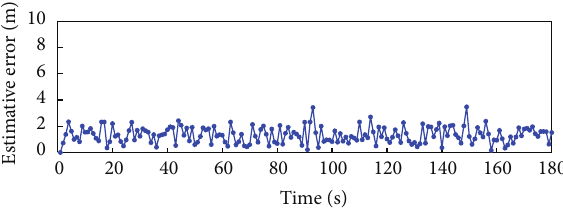
Figure 5: The estimation error for path 2 random movement.